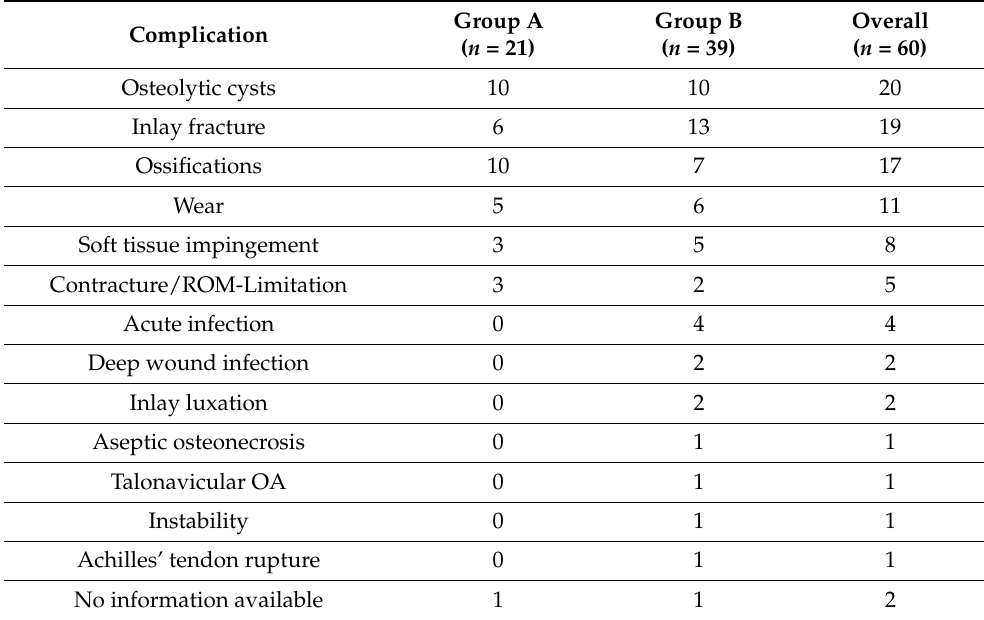
Table 2. Detailed numbers regarding the complications that led to secondary surgery. In a total of 35 cases, two or more of the complications listed below led to secondary surgery.